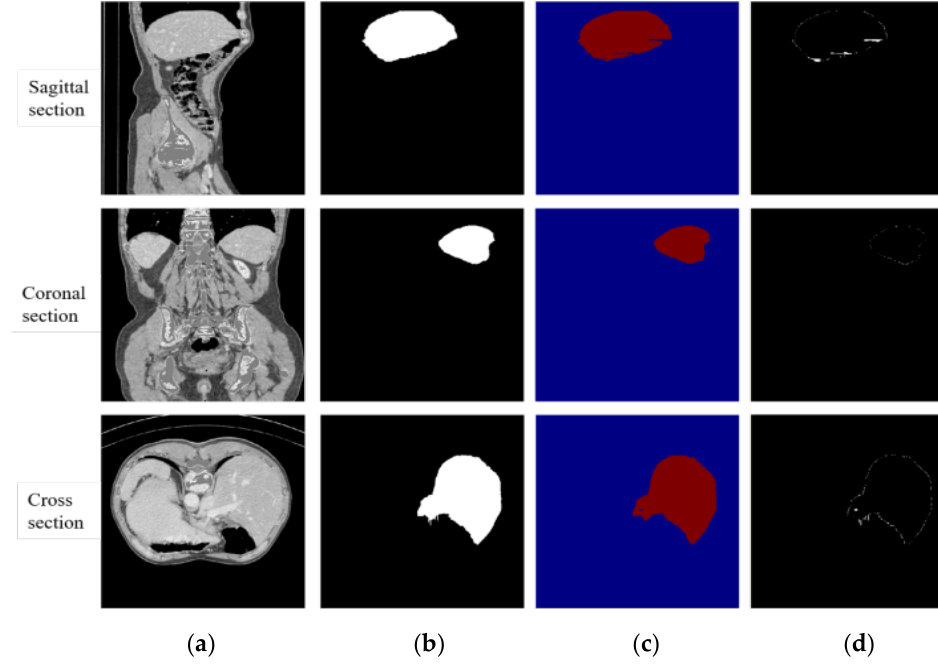
Figure 4. The segmentation results of liver localization module: ( a ) the original CT images; ( b ) the real segmentation results; ( c ) the segmentation results of DCUNet-Liver; ( d ) the difference images.